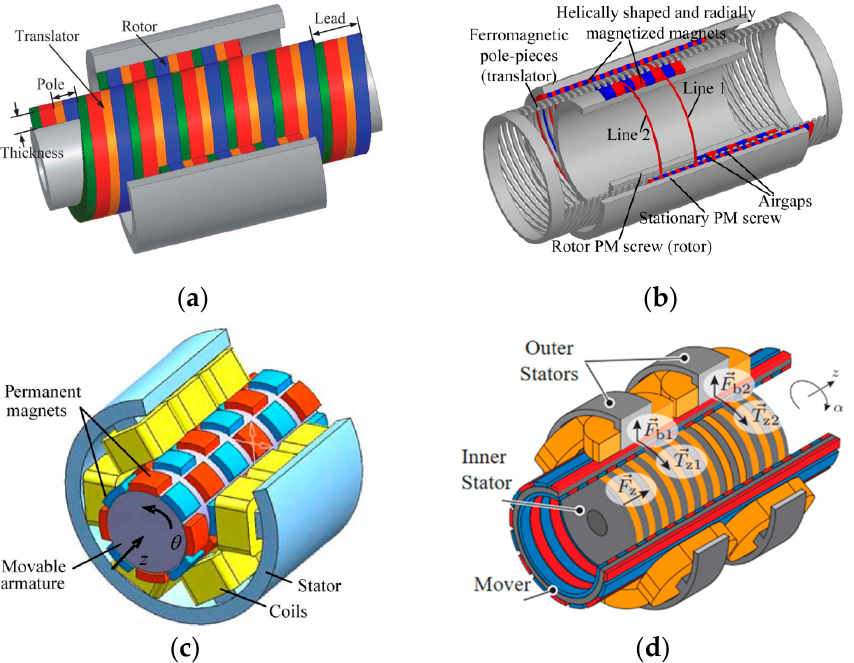
Figure 13. Linear rotary actuators; ( a ) magnetic screw–nut configuration; ( b ) field modulated mag- netic screw; ( c ) linear and rotary PM actuator with stator coils; and ( d ) self-bearing linear actuator with double stator winding. Republished with permission of AIP Publishing and IEEE.